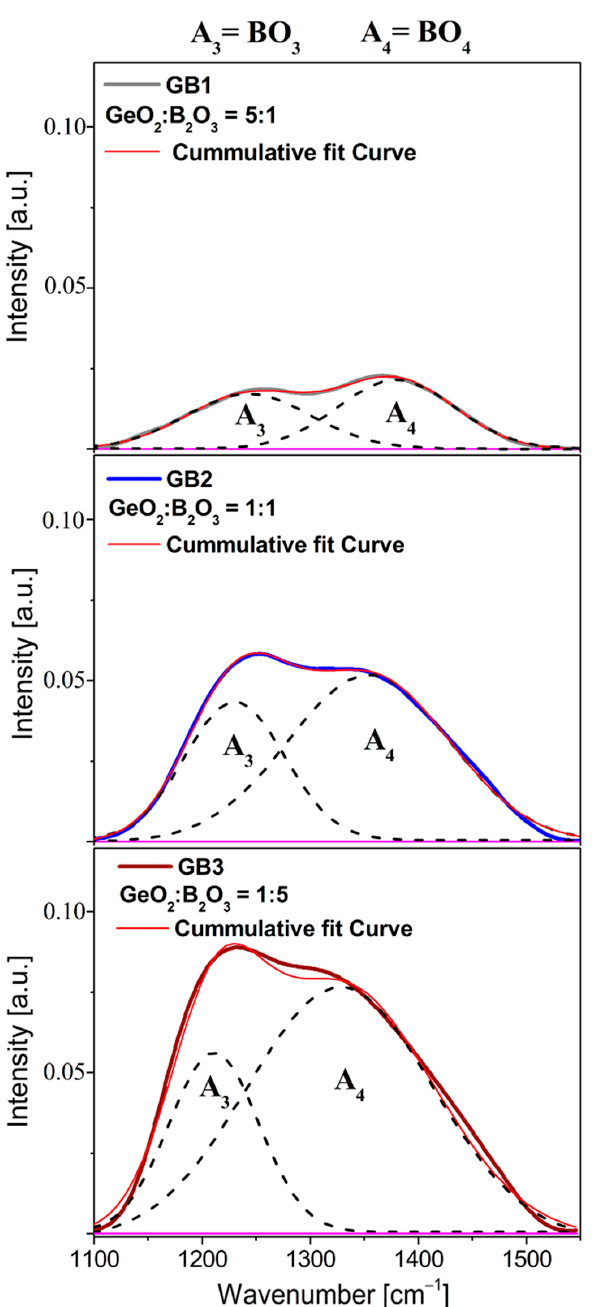
Figure 10. Deconvoluted infrared bands of series glass samples (GB1, GB2, GB3) as a function of GeO 2 and B 2 O 3 concentration in spectra range 1100–1550 cm − 1 .